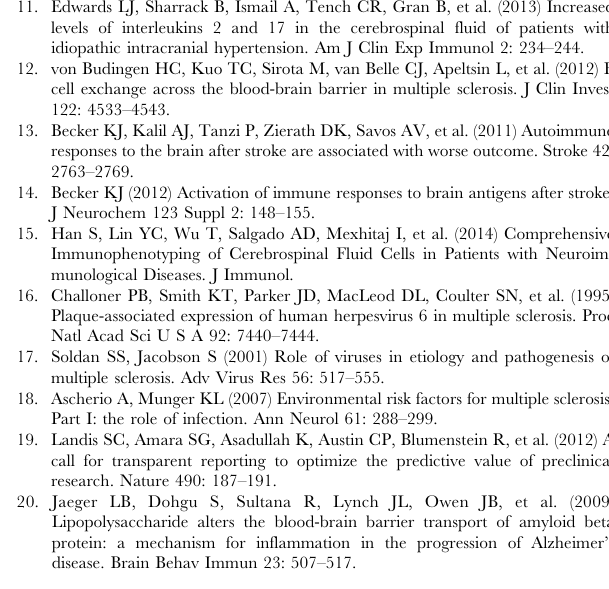
Figure S2 Negligible IL-17 and GM-CSF levels in cell culture supernatants. CSF T cell superantants were collected seven days after establishment of fresh co-cultures and analyzed for pro-inflammatory cytokines and chemokines. The groups EBV-, HHV6- or CMV-loaded co-cultures (n =31). Auto-Ag analysis involved 34 supernatants in total obtained from a combination of BH, Myelin, MO313 and SKNSH co-cultures. Results for TNF- a , IFN- c , IL-17, GM-CSF, IL-8, IP-10 and MCP-1 are presented in the bar graph as arbitrary units.